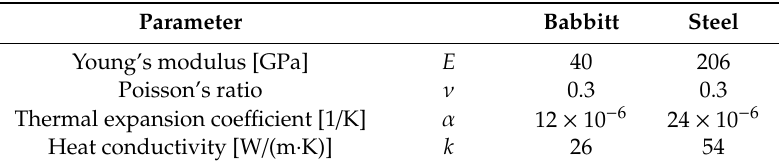
Table 2. Physical specifications of pad